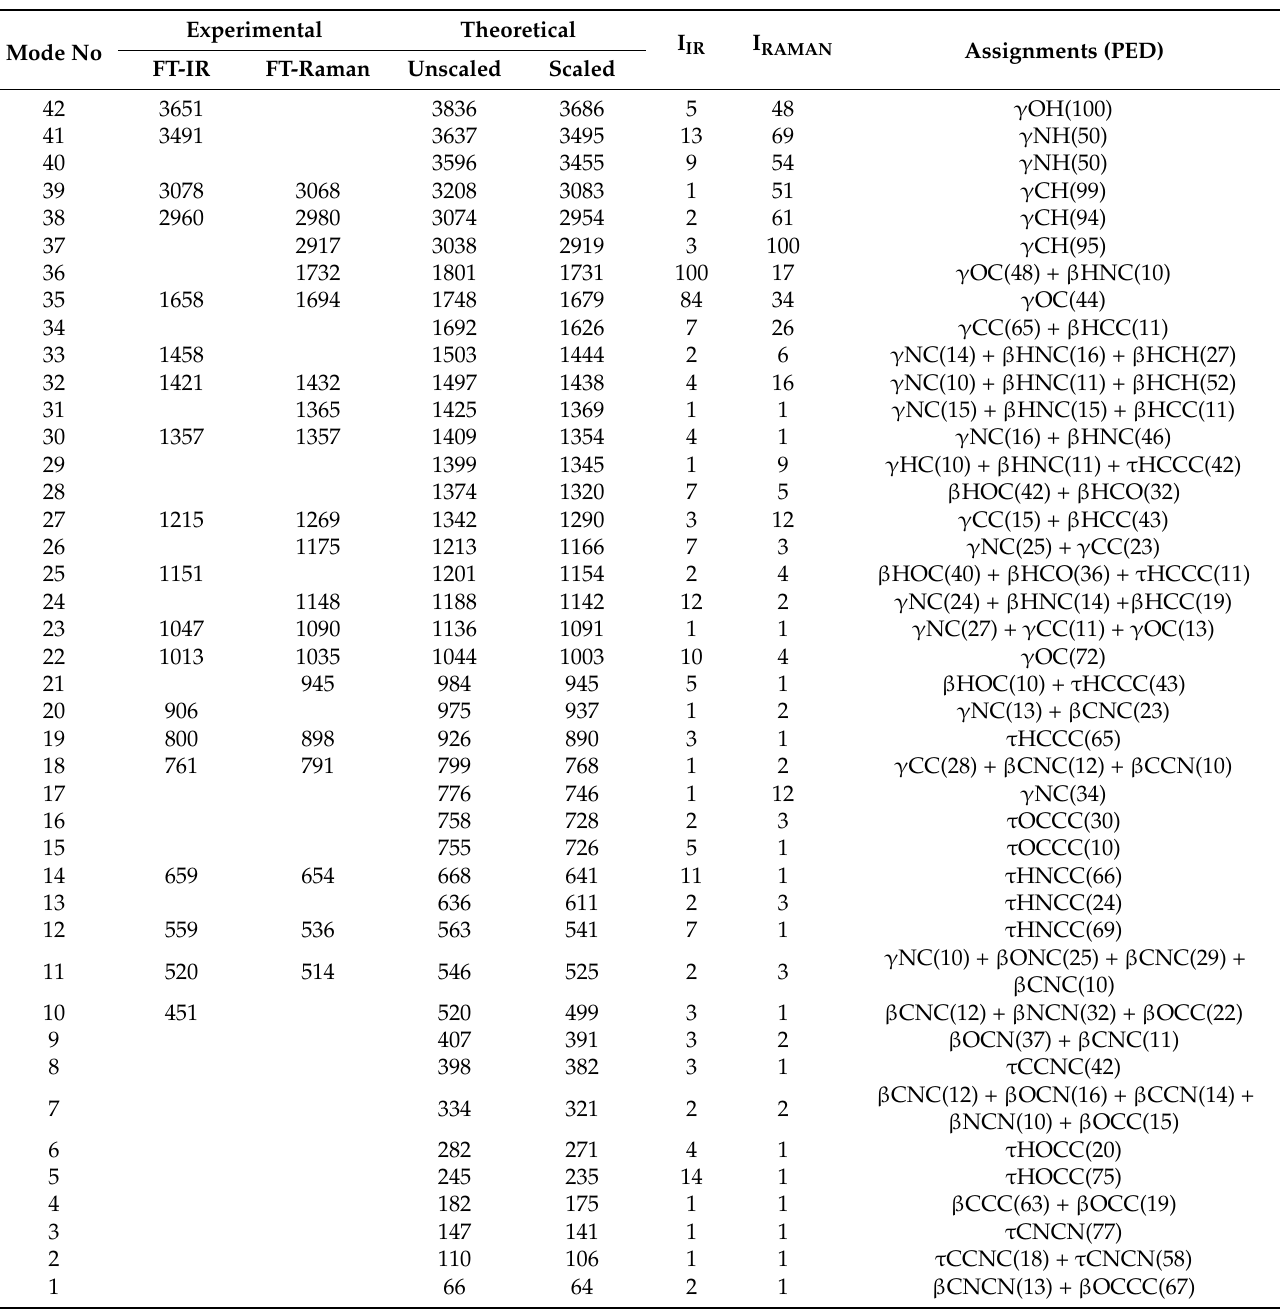
Table 2. Calculated vibrational frequencies (cm − 1 ) assignments of